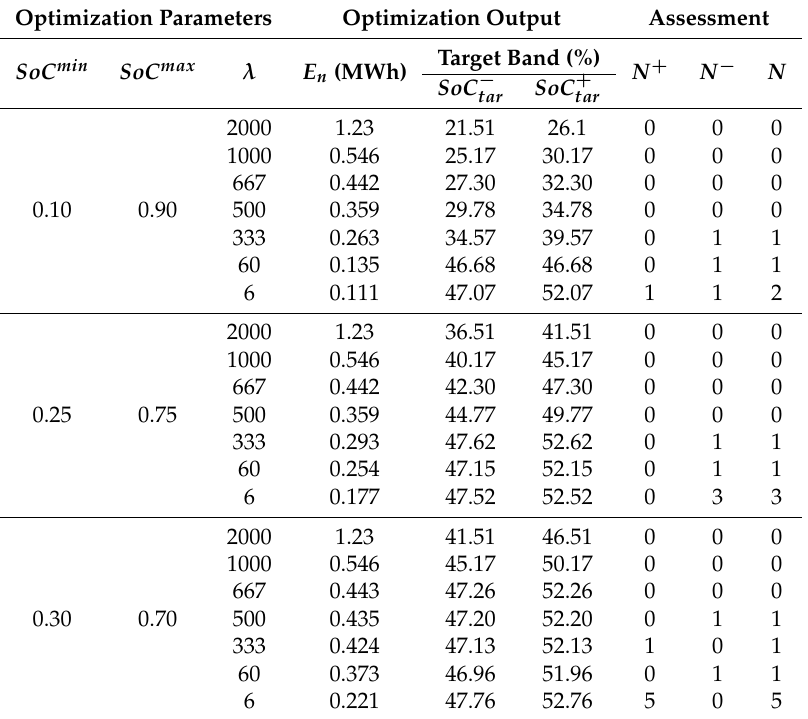
Table 1. Optimization and assessment